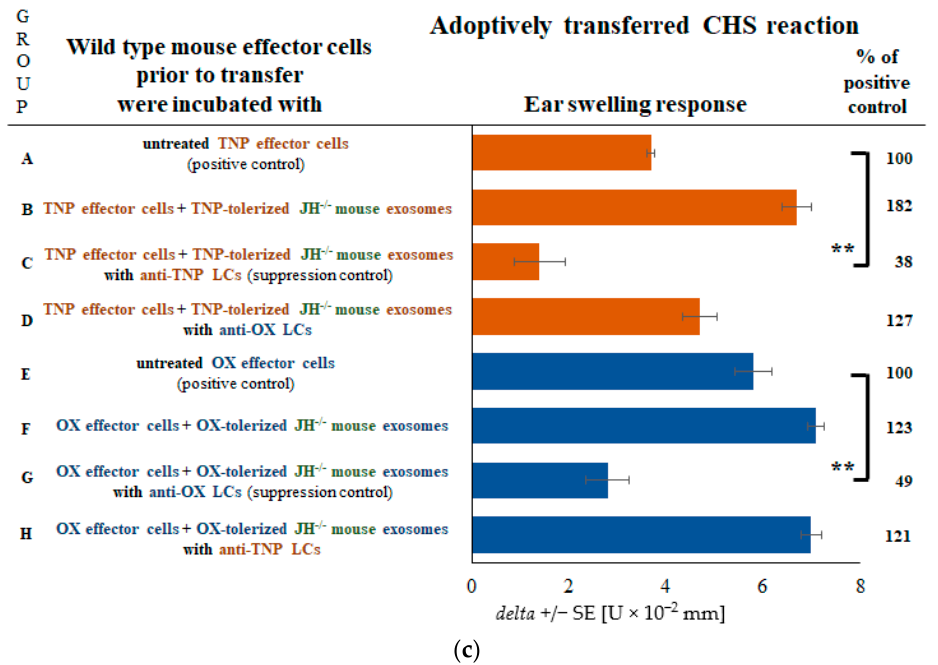
Figure 5. Effects of supplementation of exosomes from pan immunoglobulin-deficient JH − / − mice (of BALB/c background) tolerized with either oxazolone (OX) or trinitrophenol (TNP)-coupled syngeneic mouse red blood cells (MRBC) with anti-OX or anti-TNP antibody light chains (LCs) on contact hypersensitivity (CHS) reaction. CHS reaction was measured as ear swelling response in either ( a ) recipients of wild type (WT), TNP-specific CHS effector cells incubated with TNP-tolerized JH − / − mouse exosomes in some instances supplemented with anti-TNP antibody LCs or heavy chains, ( b ) recipients of WT, TNP-specific CHS effector cells incubated with anti-TNP LC-supplemented exosomes from OX-tolerized JH − / − mice, or ( c ) recipients of wild type (WT), either TNP or OX-specific CHS effector cells incubated with either TNP or OX-tolerized JH − / − mouse exosomes that have been supplemented with either anti-TNP or anti-OX LCs. Bars express delta ± standard error (SE). n = 5 mice in each group. * p < 0.05; ** p < 0.01.